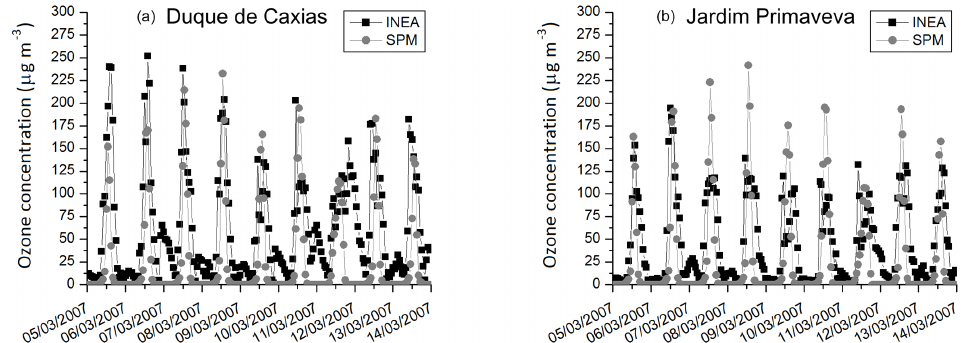
Figure 13. Comparisons between model results for ozone concentrations and observed values provided by INEA in Rio de Janeiro (adapted from Carvalho, 2010).